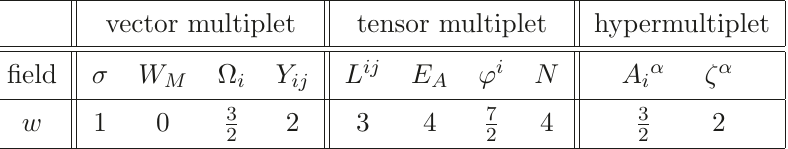
Weyl weights w of the vector multiplet, the tensor multiplet and the hypermultiplet component fields in five space-time